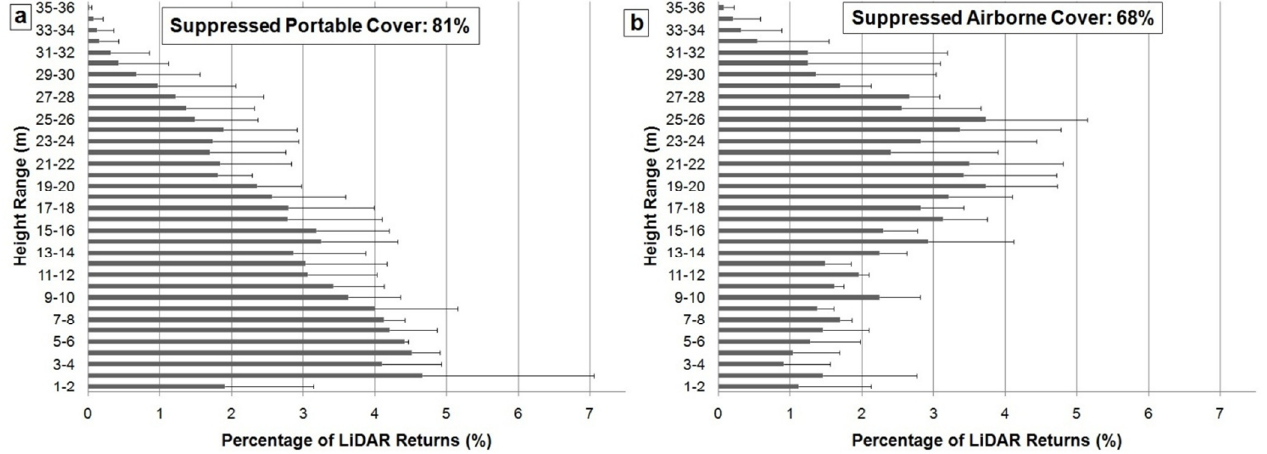
Figure 5. Vertical Distribution of Portable (a) and Airborne (b) LiDAR returns for the Suppressed Fire Treatment Plots (TTRS,